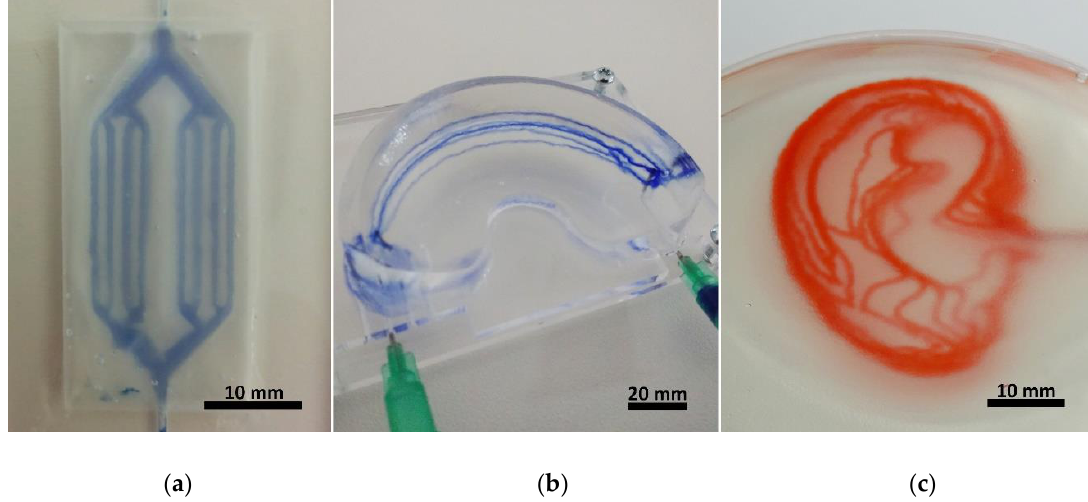
Figure 3. Photographs of the fabricated hydrogel microfluidic devices in increasing levels of complexity, made in a gelatine matrix. ( a ) shows a 2D branched geometry directly after fabrication, made in a 20 × 40 × 4 mm frame, with the channels printed at the height of 2 mm. ( b ) exhibits 5 arched channels which meet at the two ends of a meniscus shaped structure. The whole gelatinous structure (60 × 35 × 15 mm) was stable enough to keep its shape while still allowing perfusion (the channels were perfused with blue ink after releasing from mould). In ( c ) 3D earlobe shaped channels are shown, perfused with red ink. The channels are joined at the inlet/outlet points in the middle-right side of the structure, and then diverge into 9 layers, 1 mm apart. The projected earlobe is 58 mm long and 36 mm wide.